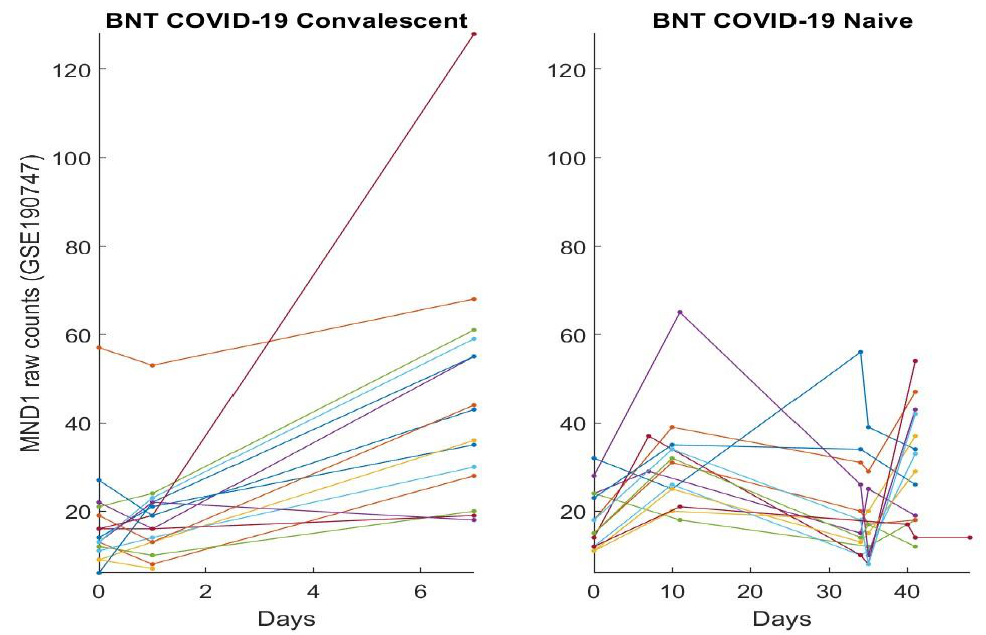
Figure 1. MND1 expression responses to BNT162b2 vaccines: The left panel is for COVID-19-recovered octogenarians; the right panel is for COVID-19-naïve individuals. Each color line corresponds to one patient’s records.